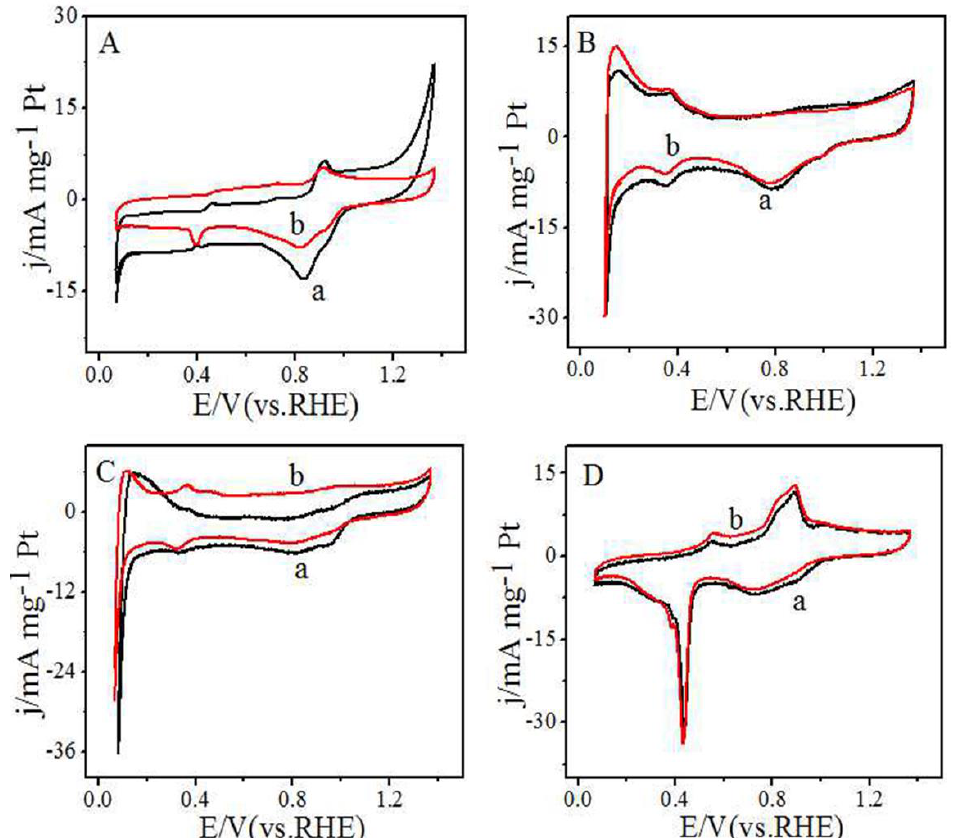
Figure 10. Cyclic voltammetry in 1.0 M NaOH saturated with oxygen: Pt-Bi (Bi 2 O 3 )/GNs (PVP) ( A ), 30% PtRu/C-JM ( B ), Pt/GNs (PVP) ( C ) and Pt-Bi (Bi 2 O 3 )/GNs ( D ), curve a: under simulated sunlight irradiation, curve b: without irradiation.